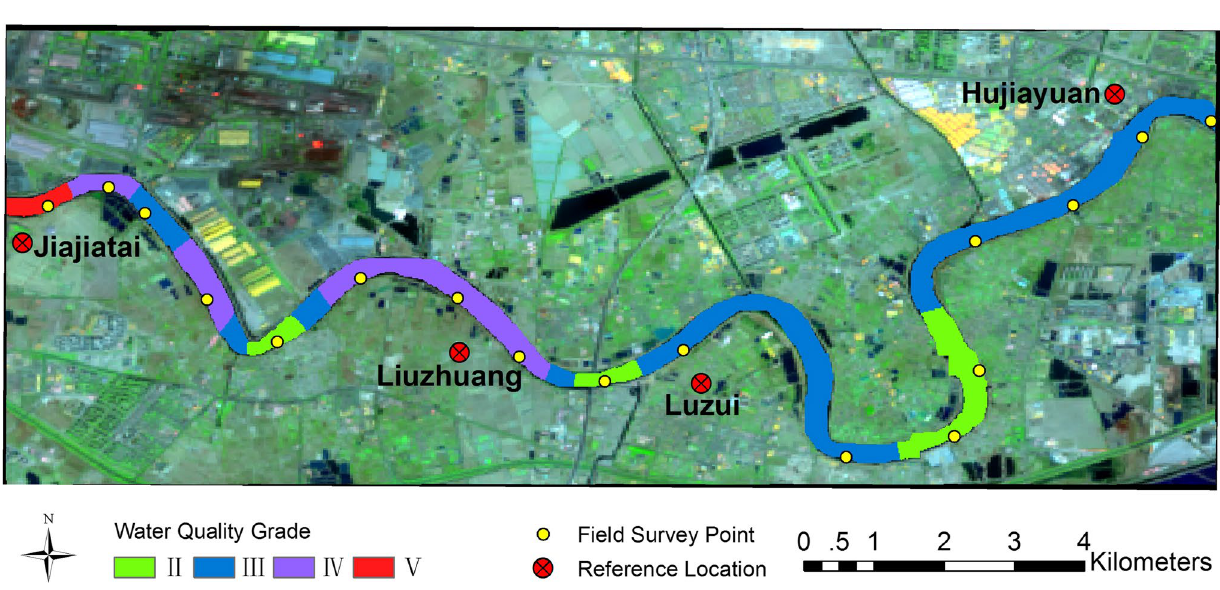
Fig. 6 Partial enlargement map of Kriging interpolation results for the water quality sampling